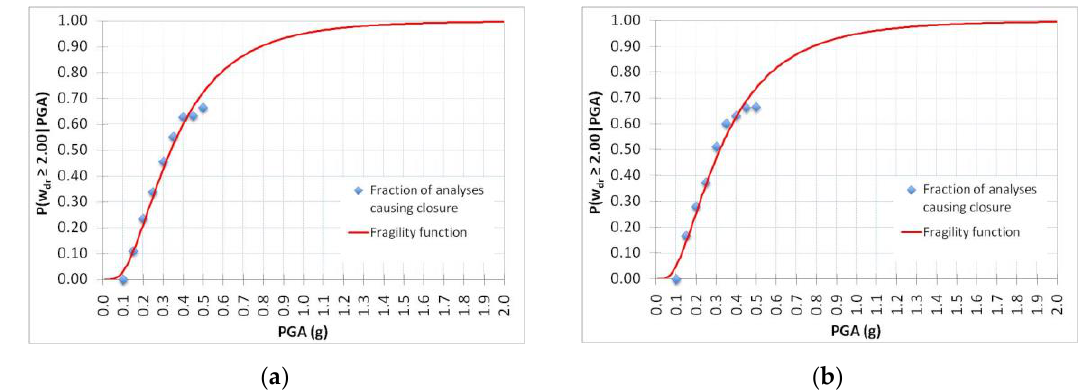
Figure 9. Fragility curve in terms of probability of closure for ( a ) AC1 and ( b ) AC2.